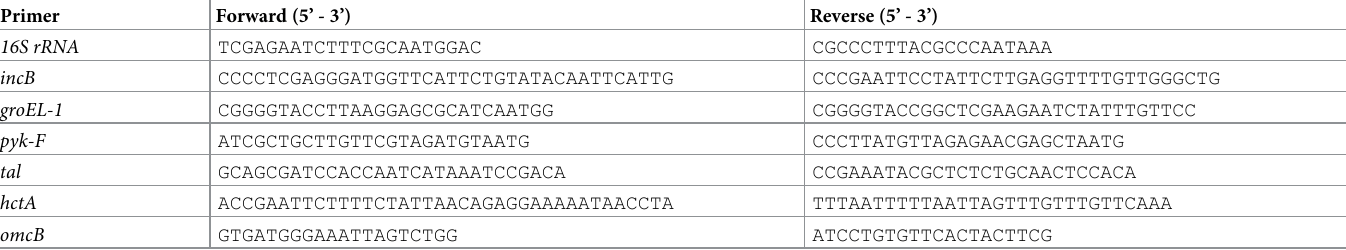
Table 1. Primer sequences of the groEl-1 , incB , pyk-F , tal , omcB , hctA genes and 16S rRNA reference gene used in the real time